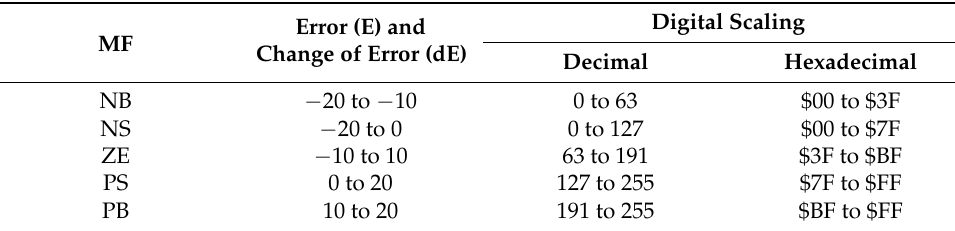
Table 1. Membership Function (MF) of Error (E) and Change in Error (dE) with digital scaling format (Decimal and Hexadecimal). The input MFs are Negative Big (NB), Negative Small (NS), Zero (ZE), Positive Small (PS) and Positive Big